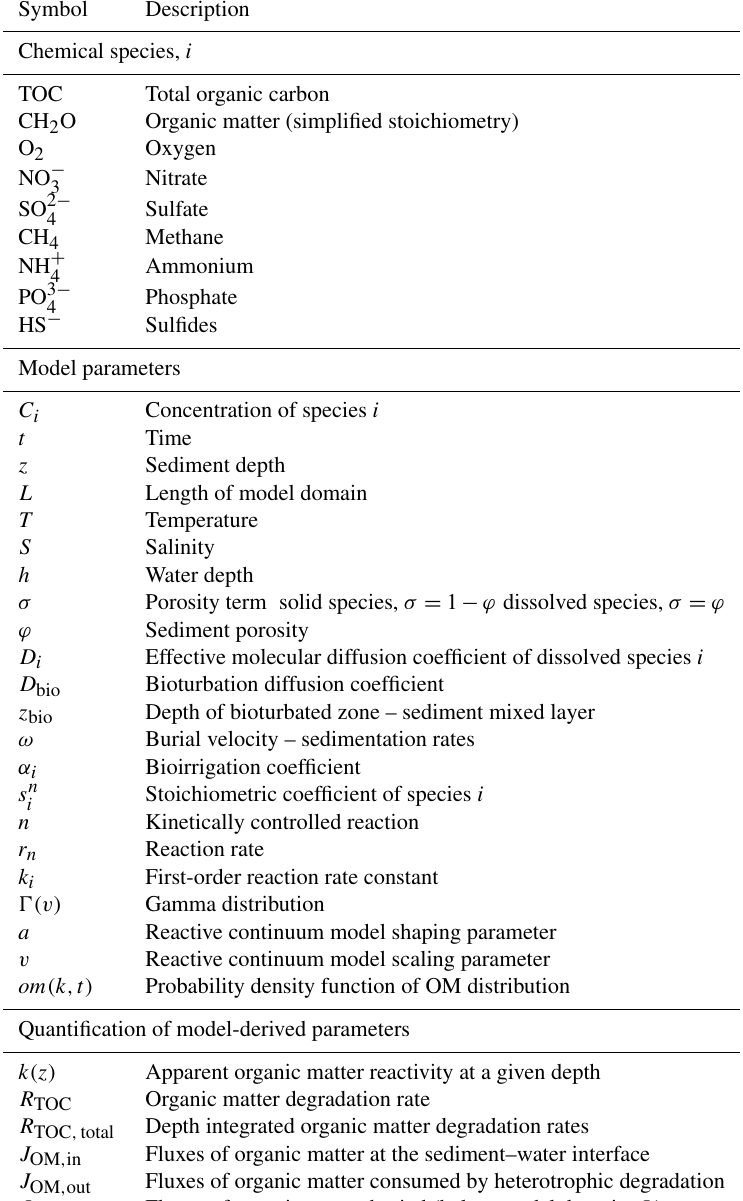
Table 3. Summary of model elements incorporated in the